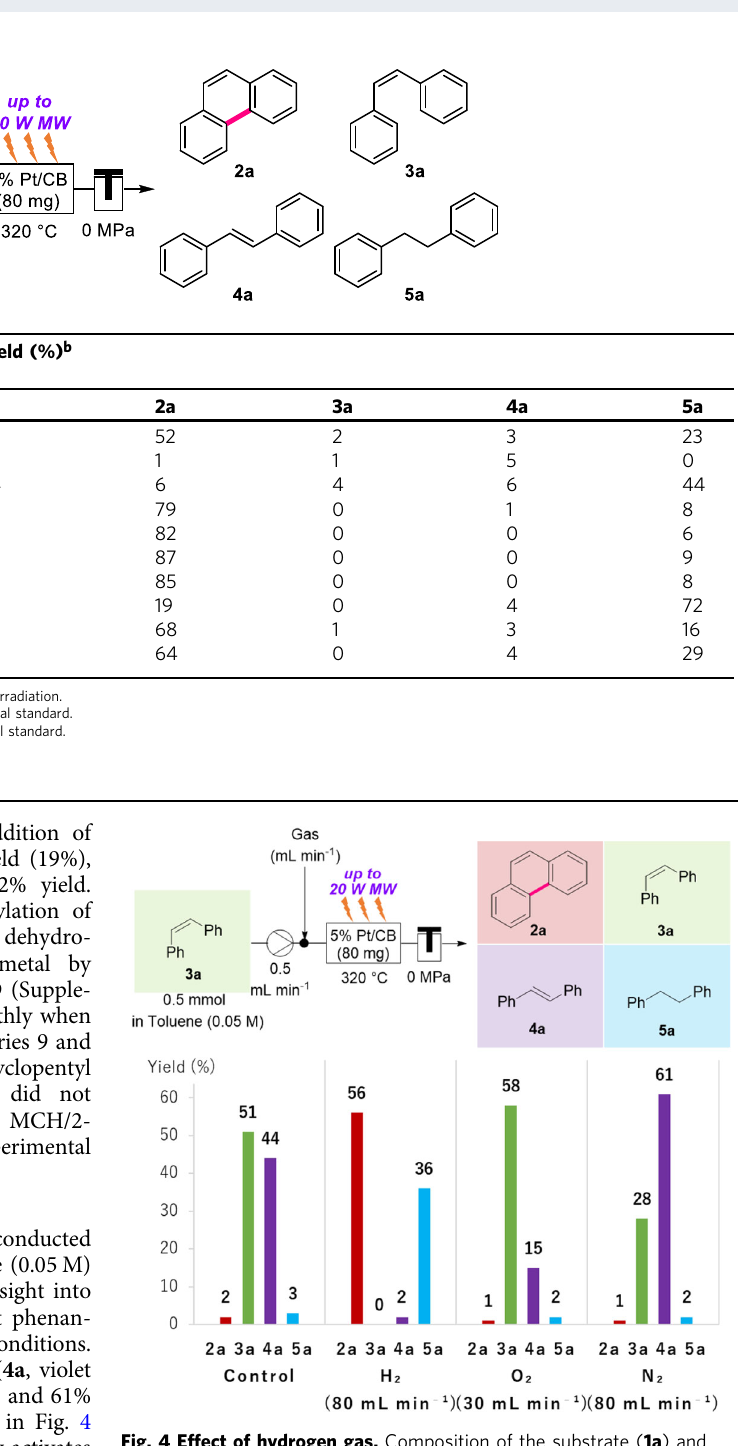
Fig. 4 Effect of hydrogen gas. Composition of the substrate ( 1a )